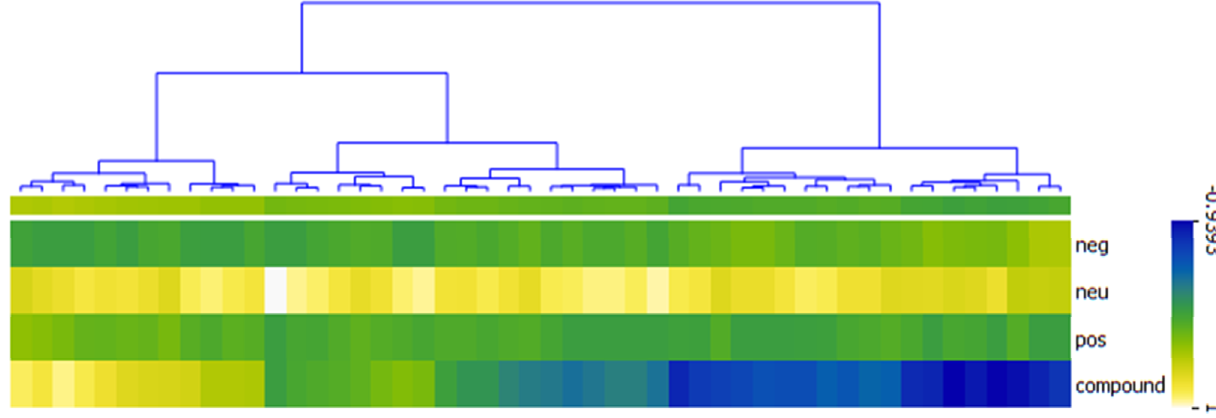
Figure 7. Heat map showing sentiments classification using VADER method.